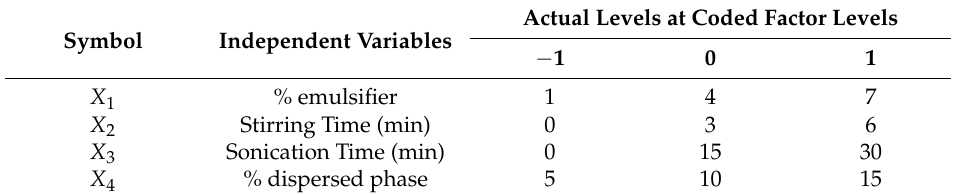
Table 6. Actual levels at coded factor levels of independent variables used in the RSM.